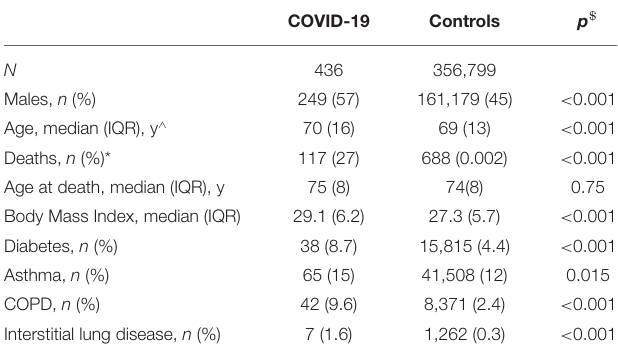
TABLE 2 | Characteristics of UK biobank participants.